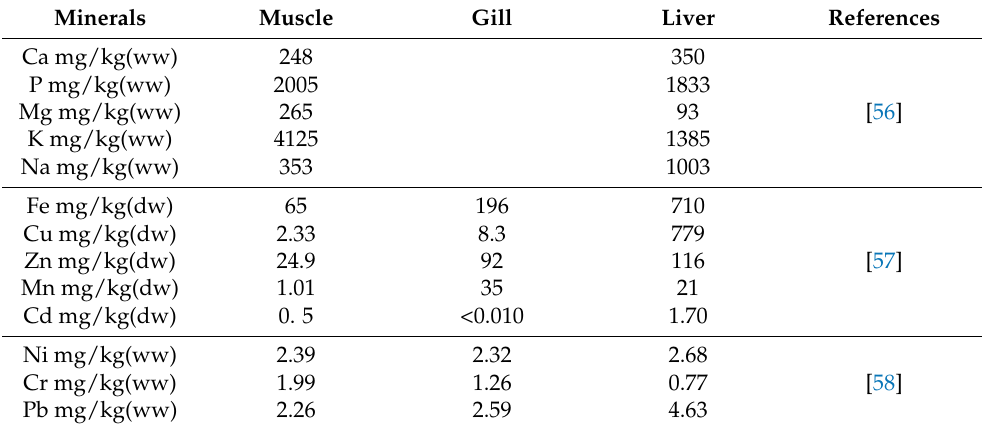
Table A2. Summary of minerals and toxic elements reported by different authors from Nile tilapia tissues.